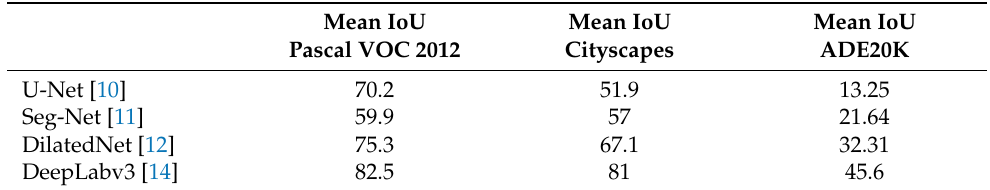
Table 3. Mean IoU for Pascal VOC 2012, Cityscapes and ADE20K datasets evaluated on U-Net [10], SegNet [11], DilatedNet [12] and DeepLabv3